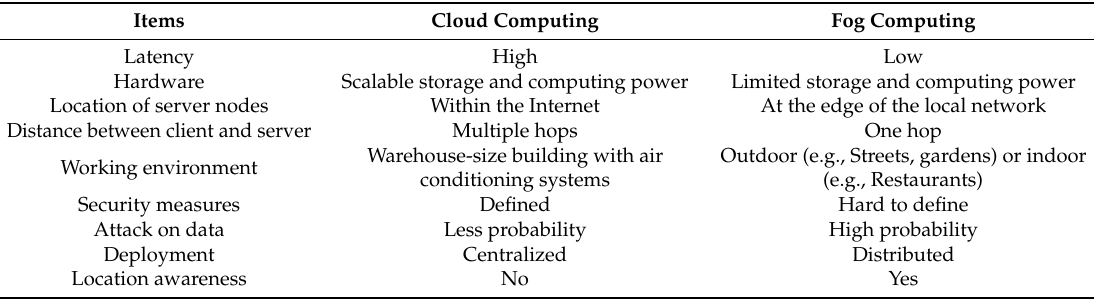
Table 1. Comparison between cloud and fog